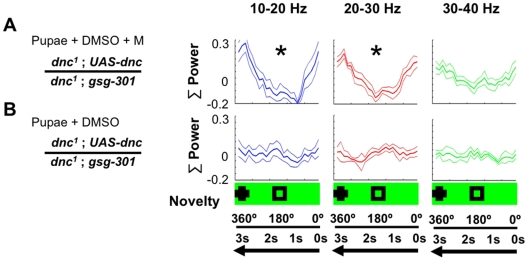

dunce1 temporal rescue.A. Injection of Mifepristone (M) in pupae (see Methods) to activate dunce expression throughout mutant dnc1 brains rescued (*, P<0.05, by Wilcoxon rank sum) the selective novelty response across two frequency domains. N = 5 flies. B. Injection of only the vehicle (DMSO, see Methods) in pupae of the same strain as in A did not produce any significant novelty responses in adult flies. N = 5 flies. Baseline responses immediately preceding novelty are shown in Figure S6.